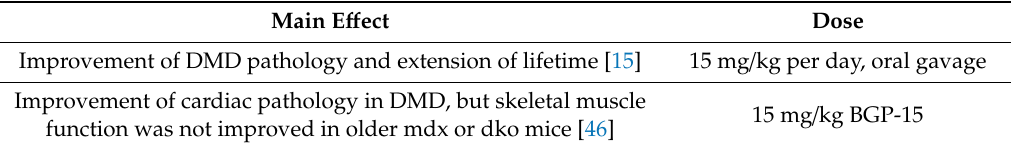
Table 3. Summary of the investigations related to the of BGP-15 in the therapy of